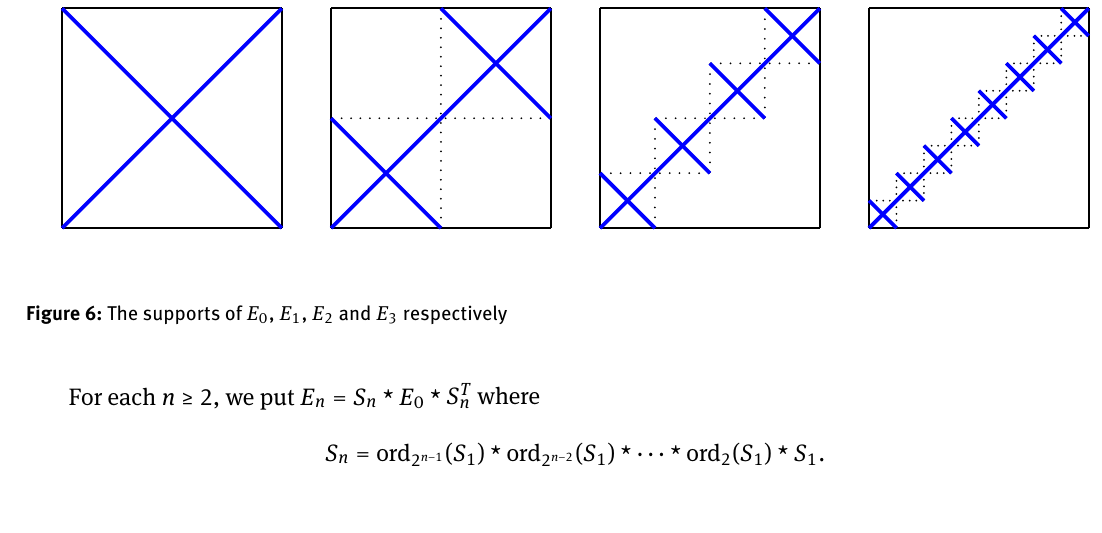
For each n ≥ 2 , we put E n = S n * E 0 * S T n